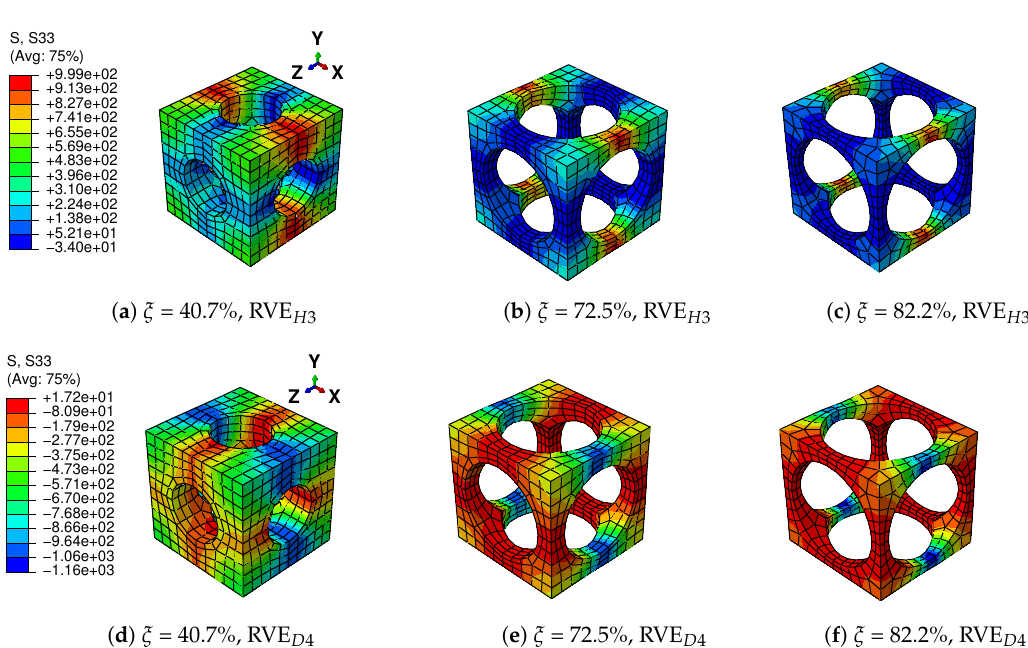
Figure 21. Distribution of stress in Z direction (S33) on RVE H 3 and RVE D 4 of different beams corresponding to the displacement of the beam ends U 2 = 0.5